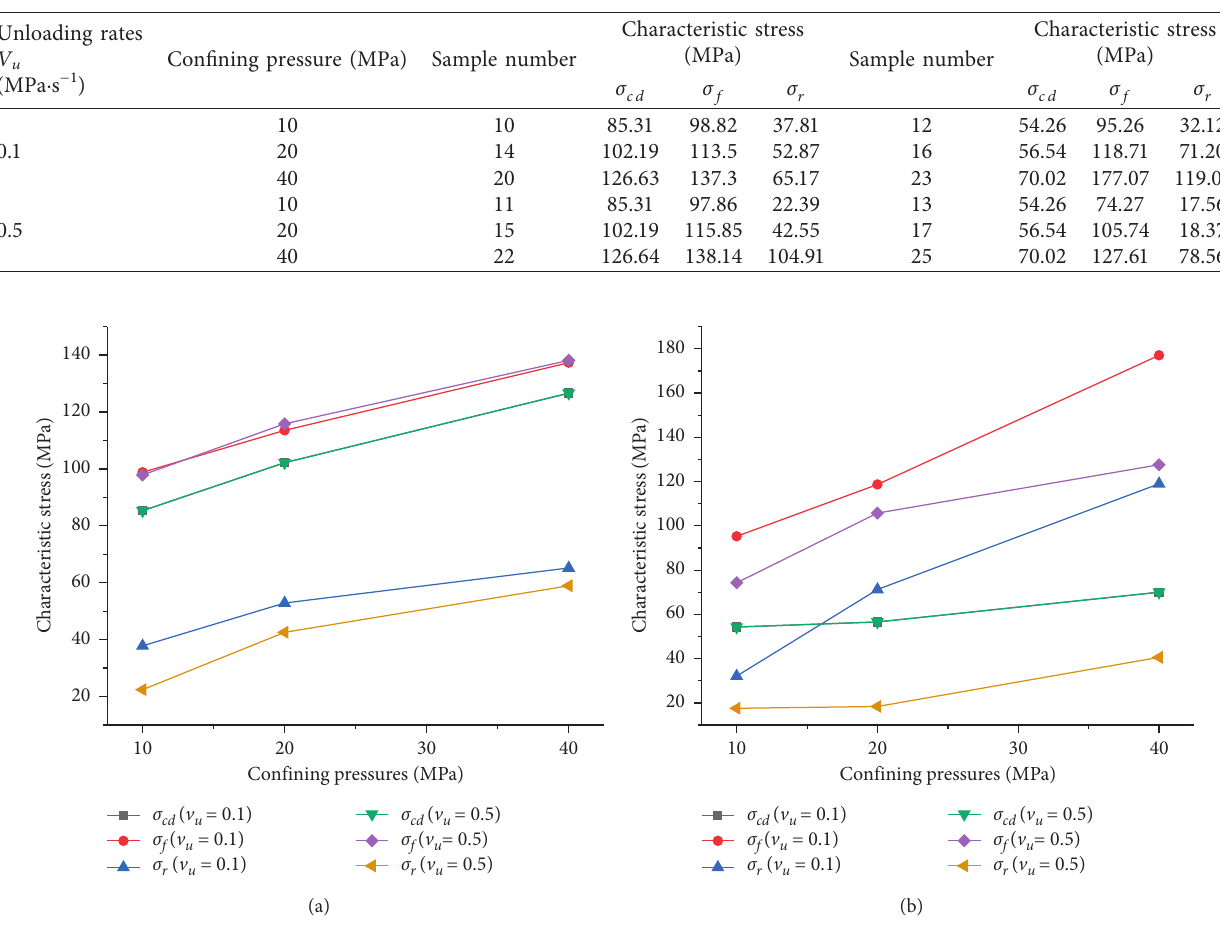
Table 4: Characteristic stress of rock under complex loading and unloading conditions.